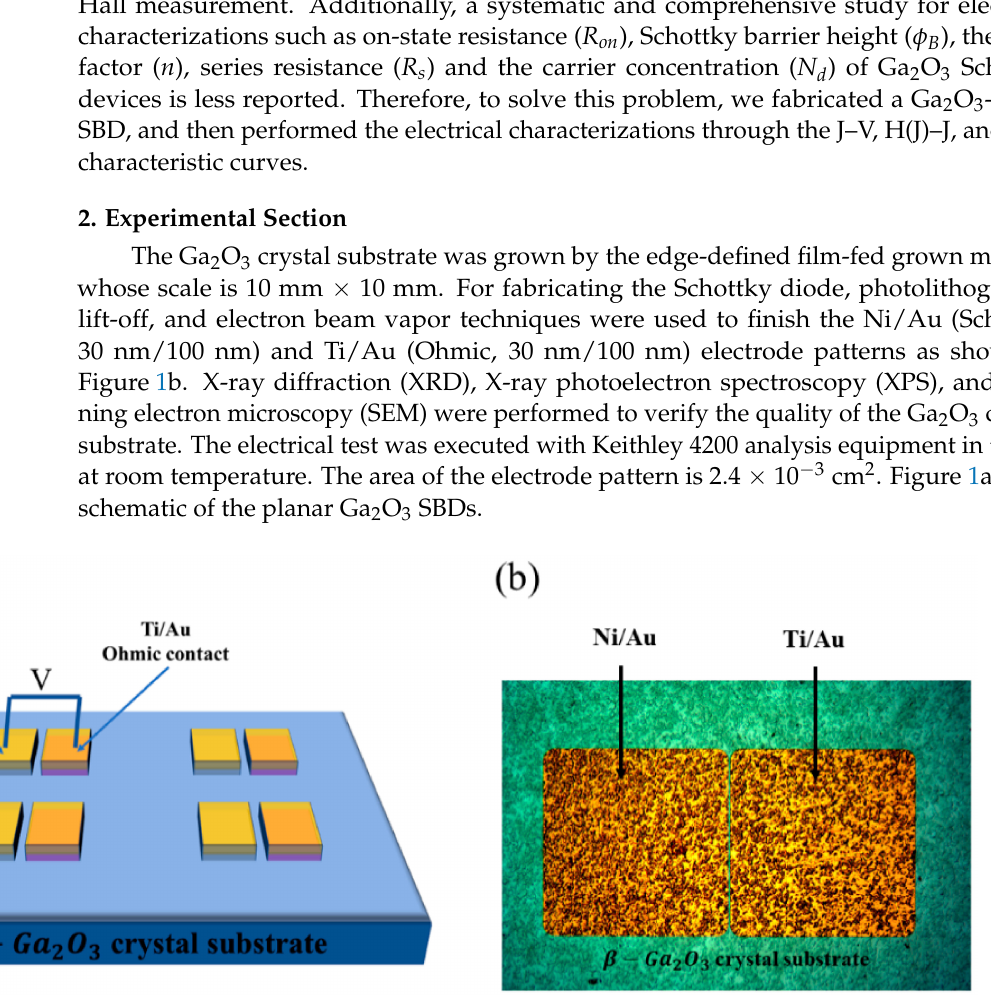
Figure 1. ( a ) The geometry of the Schottky diodes with Ni/ β − Ga 2 O 3 /Ti structure. ( b ) Optical microscopy image of the fabricated Schottky